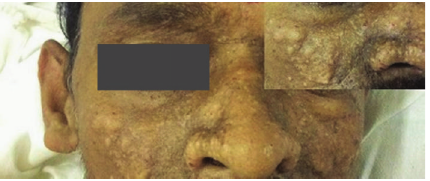
Figure 1: Face monograph showing skin colored, nonpruritic, nontender, papulonodular lesions (few umbilicated). Inset showing close-up view of right side facial lesions. Gray bar was used to mask face